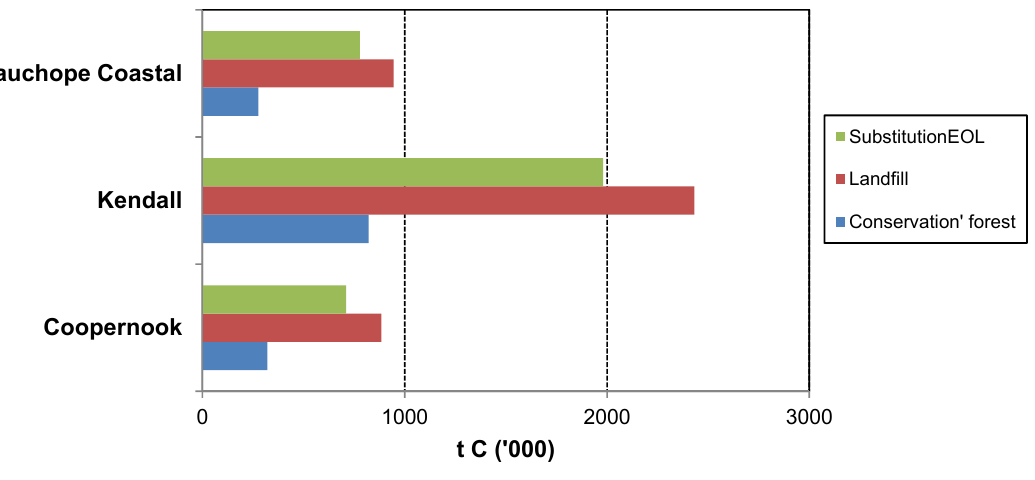
Figure 12. Total C mitigation benefits (t C) over 200 years from the “Landfill” and ” options for HWPs compared to the “ conservation ” scenario in the NC “Substitution EOL forest simulation.